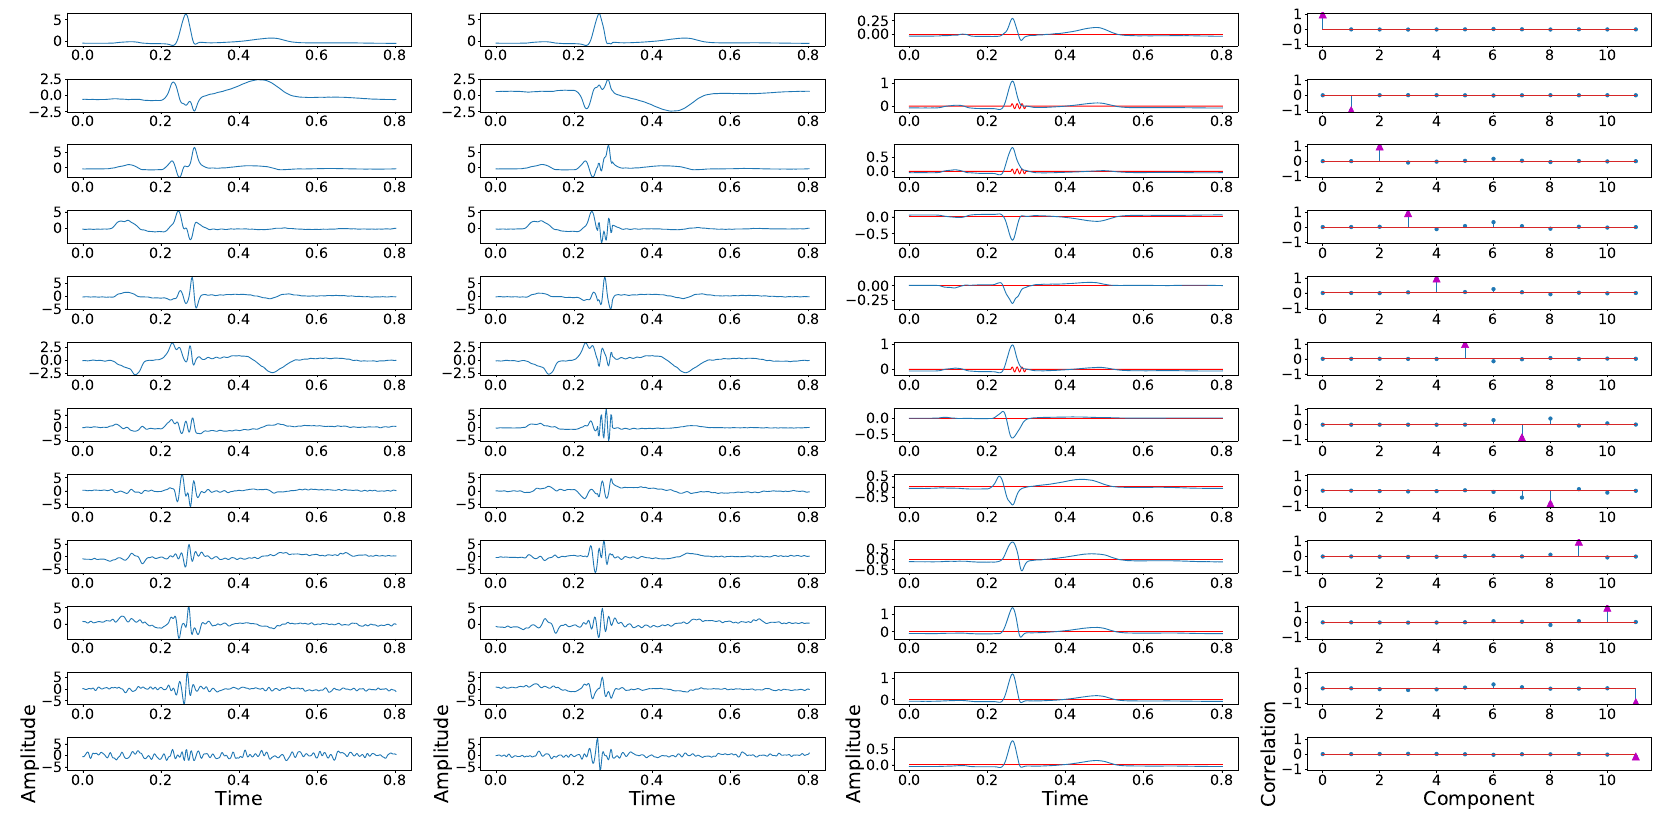
Figure 2. Example of principal components position swapping in twelve-lead PCA model. The first column shows the principal components of a control ECG, the second column shows the principal components of a synthetically fragmented replication of the previous control ECG, the third column shows the control ECG in blue, and the fragmented wave added in red. The fourth column shows the PCC between the i-th principal component of control ECG with each component of synthetically